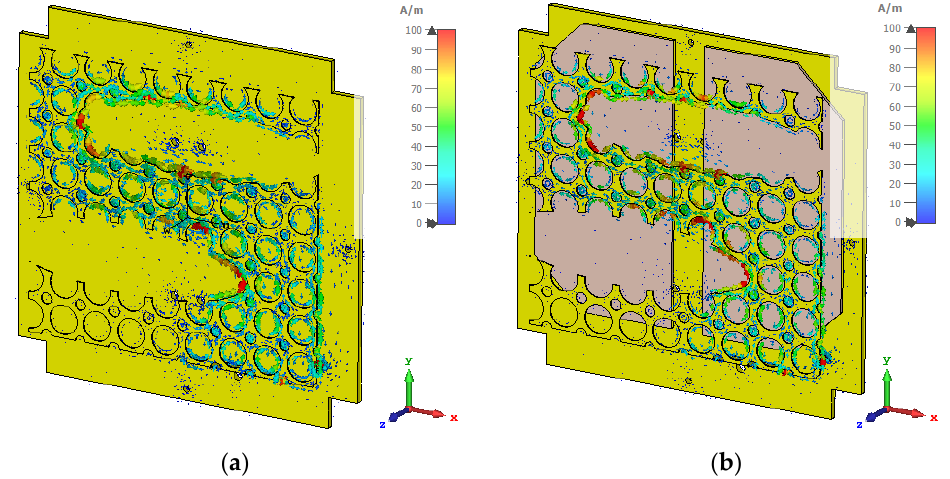
Figure 3. Surface current distribution of the proposed antenna — ( a ) only antenna and ( b ) antenna with solar panel.